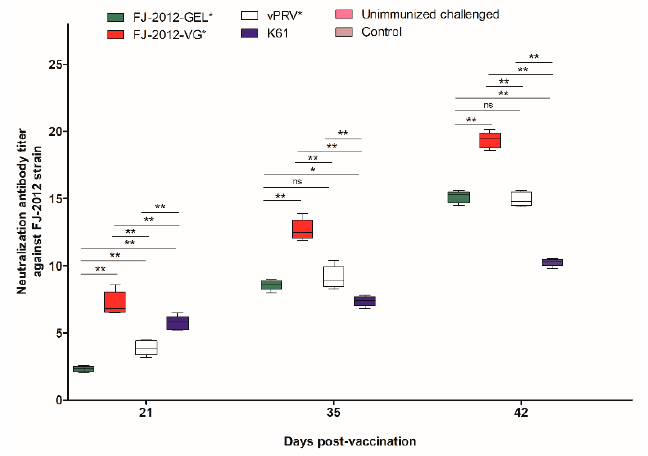
Figure 2. The neutralizing antibody titers of immunized piglets ( n = 5) in a vaccination group. At 21, 35, and 42 days post-immunization, serum samples were collected and tested by SVNT. Statistical analysis was performed using GraphPad Prism version 6.0 for Windows (Dr. Harvey Motulsky, GraphPad Software, CA, USA). Pairwise comparisons of neutralizing antibody titers between different groups were performed by one-way ANOVA, followed by Tukey’s multiple comparison test. Significant differences ( p < 0.01) are marked by **; ( p < 0.05) by *; and no significant difference by ns.